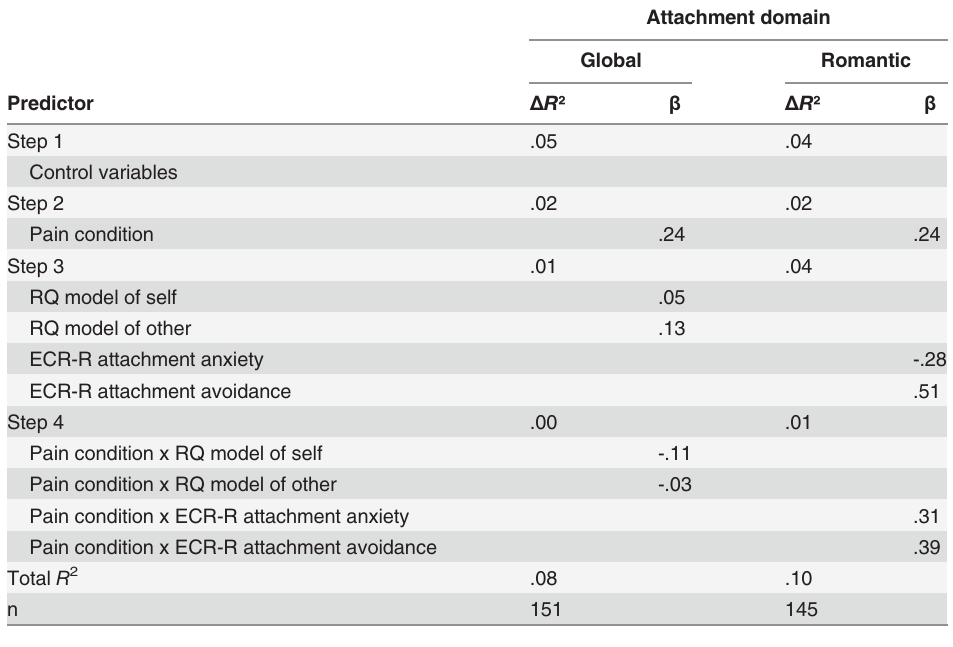
Table 6. Regression analyses predicting disability from pain condition, attachment dimensions, and interaction between pain condition and attachment